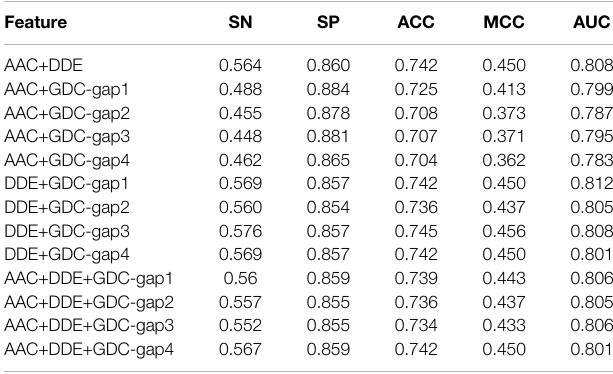
TABLE 3 | Performance comparison of various combined features on the independent